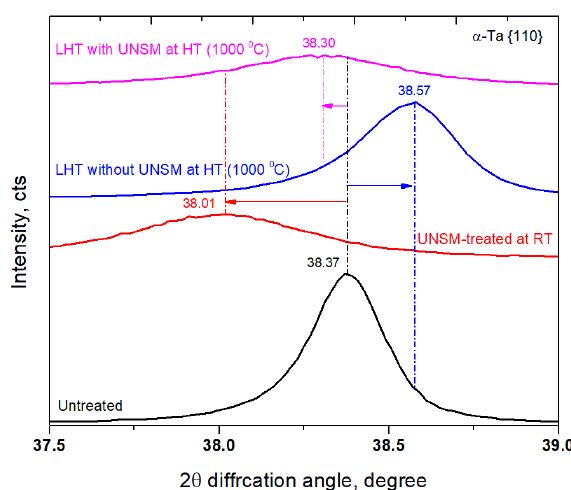
Figure 5. Comparison in intensity peak {110} shift to lower and higher angles of the untreated, UNSM-treated at RT, LHT without and with UNSM treatment specimens.